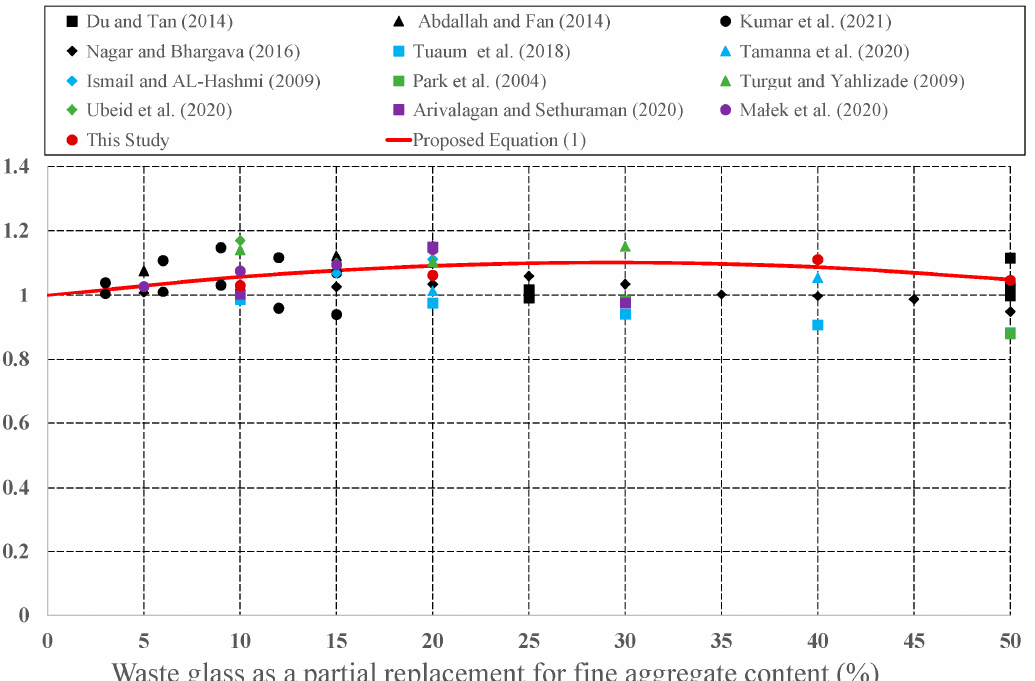
Figure 13. Discrepancy of the normalized FS of the concrete produced with CWG as a partial replacement for FA [29,33,35,44,46,63,64,66,68,75,76,80]. Considering both our findings and previous studies, an empirical equation was developed as follows to predict the CS, STS, and FS, respectively: 𝑓 (cid:3404) (cid:4670) 1 (cid:3397) 𝑐 (cid:2869) (cid:3400) (cid:4666)𝑊𝐺𝑅(cid:4667) (cid:3397) 𝑐 (cid:2870) (cid:3400) (cid:4666)𝑊𝐺𝑅(cid:4667) (cid:2870) (cid:4671) (cid:3400) 𝑓′ (1) where f = strength values to be calculated ( f c = CS; f s = STS; f f = FS); c 1 and c 2 = the coeffi ‐ cients given in Table 2; WGR : CWG proportion (0 < WGR < 50); and 𝑓 (cid:4593) = strength values of the plain concrete. Table 2. The parameters used in Equation (1).